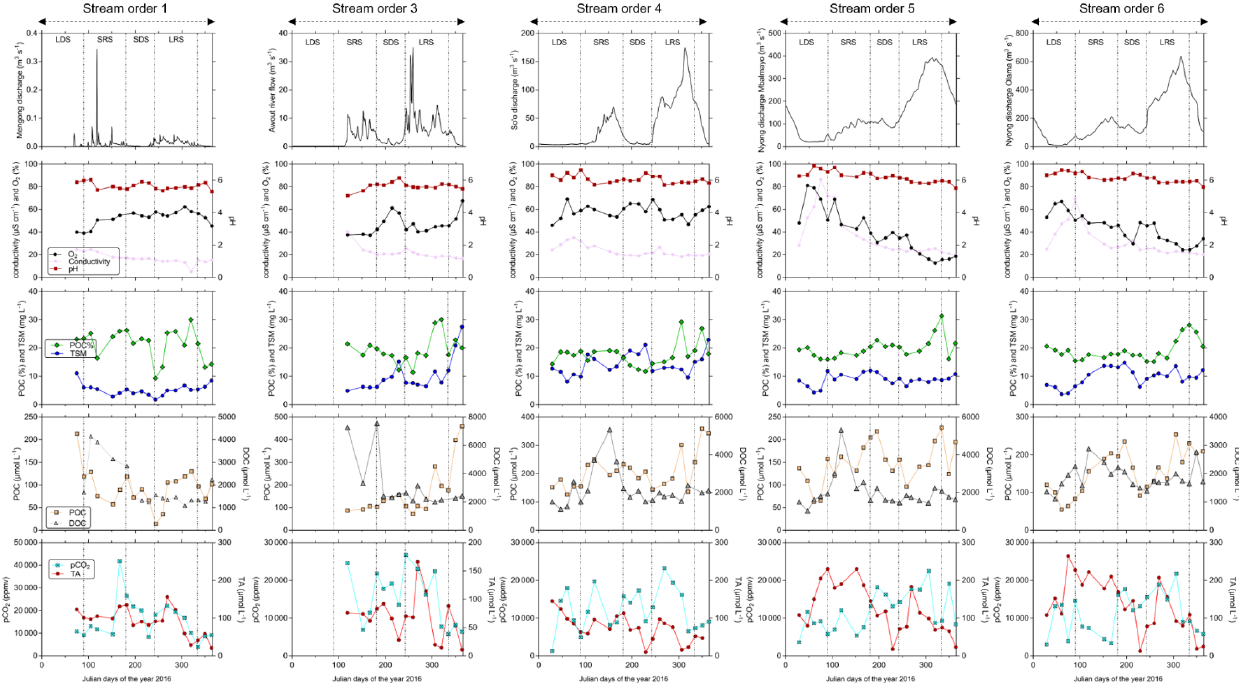
Figure 5. Temporal variations in river discharge, carbon ( p CO 2 , TA, DOC, POC) and ancillary parameters (oxygen saturation as O 2 , pH, conductivity as specific conductivity, TSM) in surface waters of the Nyong watershed. The temporal variations are separated into the four seasons that occur in the Nyong watershed: LDS – long dry season, SRS – short rainy season, SDS – short dry season and LRS – long rainy